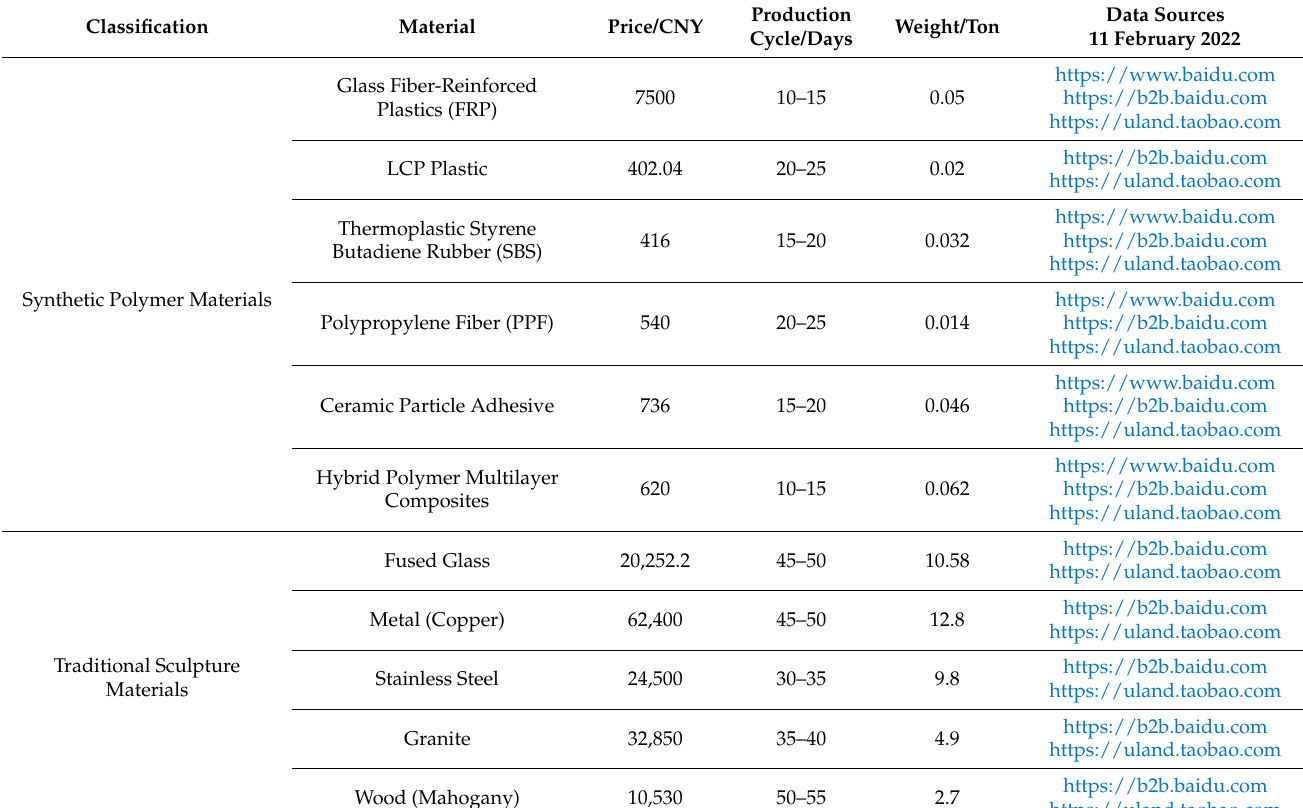
Table 5. Comparison of production price, production cycle and weight of different materials for sculptures of the same size (2.4 m × 1.1 m × 1.9